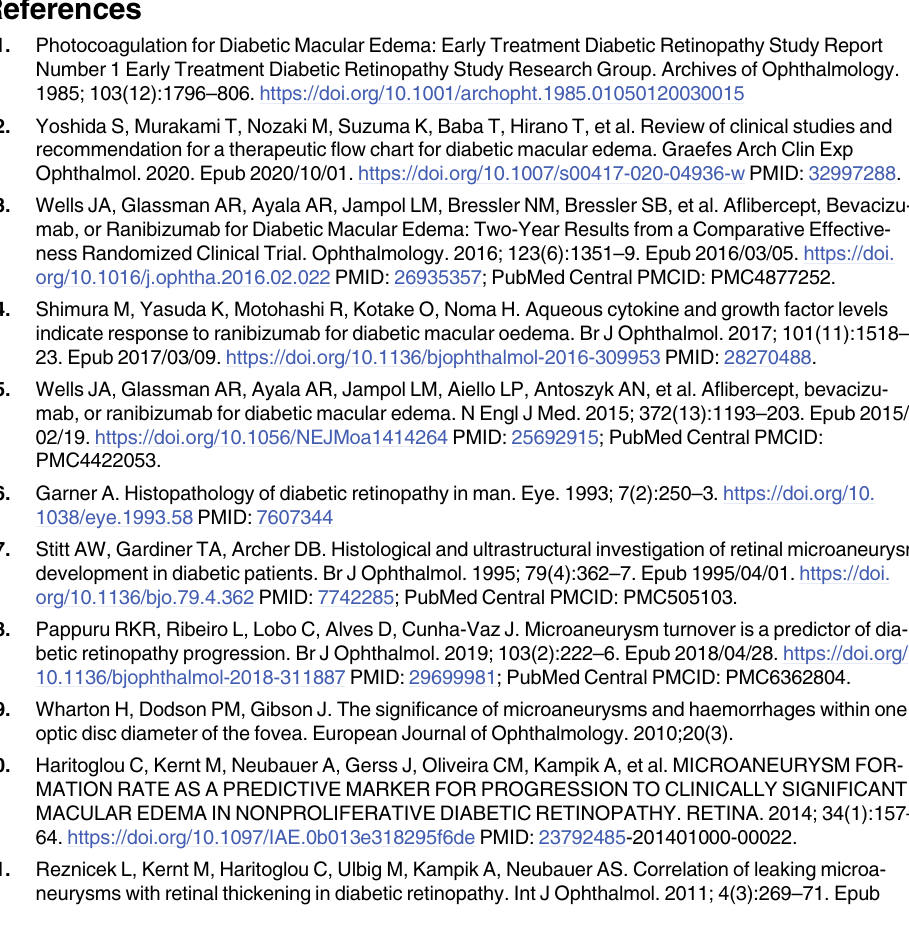
S4 Table. Minimal data set of the number of detected MAs by OCTA. The number of MAs counted by three measurers in each area on